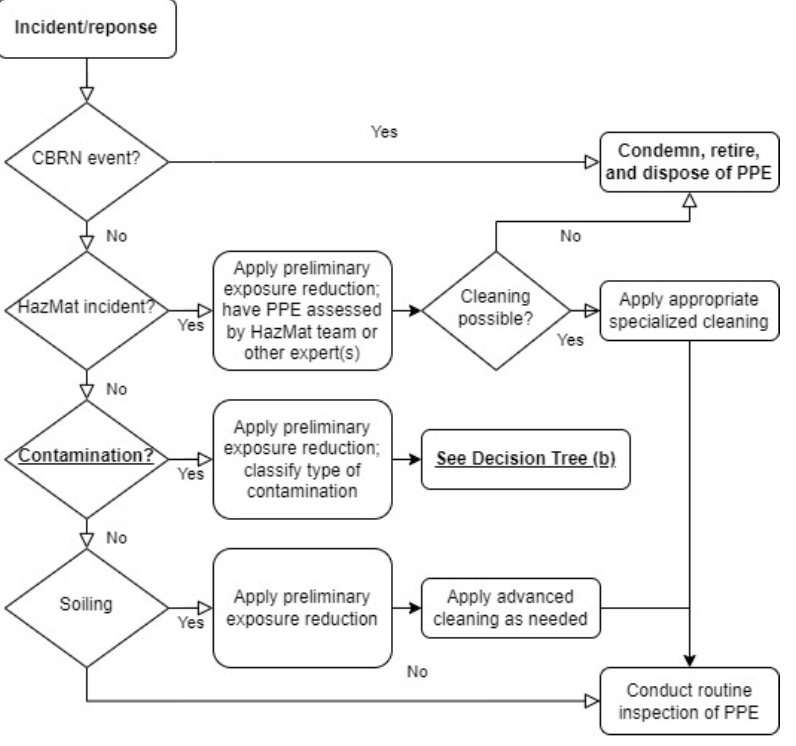
Figure 1. Approach for deciding handling, cleaning, and disposal of ensemble elements according to NFPA 1851 [29].